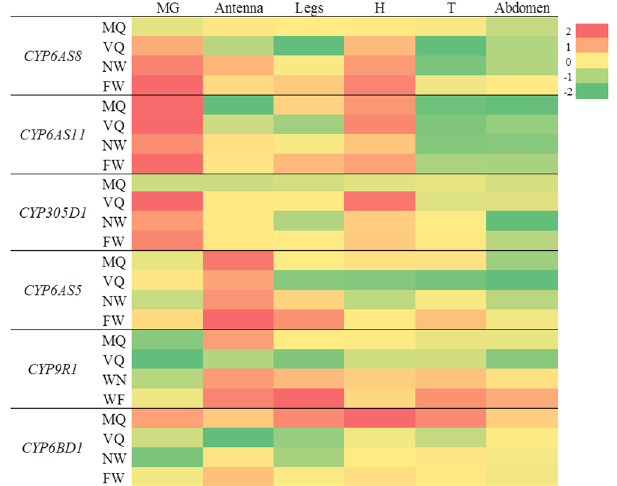
Figure 4. Heat map representing the expression patterns of CYT P450 genes. MGs from MQ was used as reference sample and the relative expression levels were log2 transformed. Experimental groups: Mated queen (MQ), virgin queen (VQ), nurse worker (NW) and forage workers (FW). Organs and segments: Mandibular gland (MG), antenna, leg, head without mandibular gland and antenna (H), thorax without legs (T) and abdomen were collected and analyzed using quantitative PCR